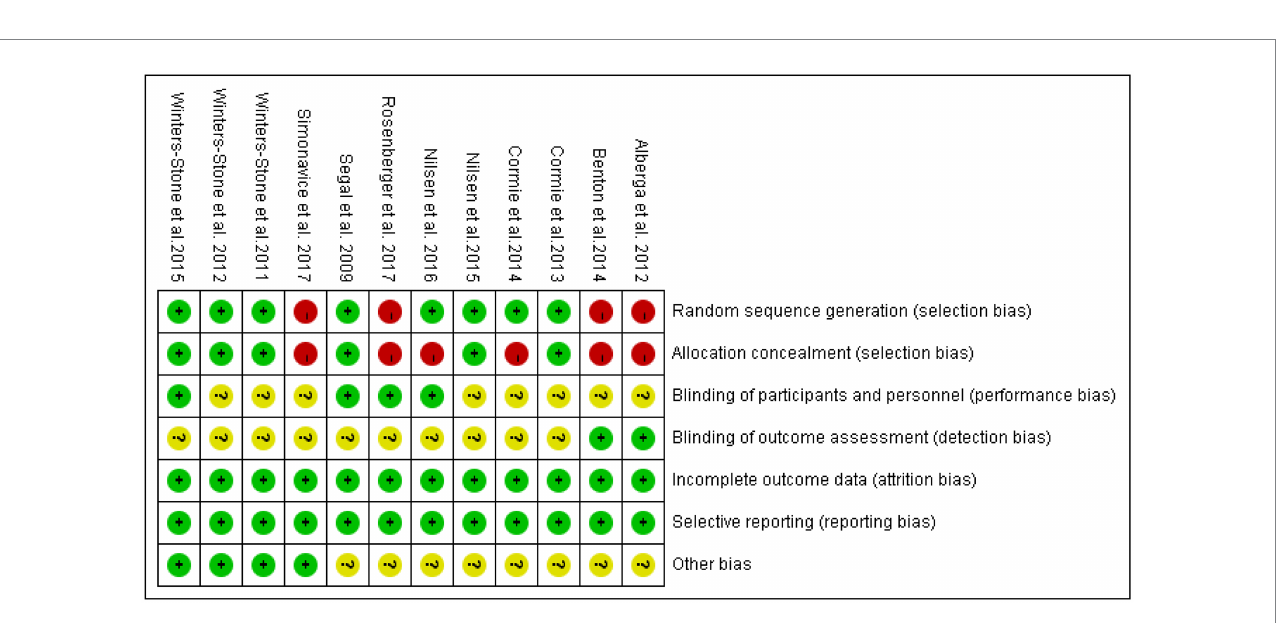
FIGURE 4 Summary diagram of the included literature with quality assessment. Green represents low risk, yellow represents unclear risk, red represents high